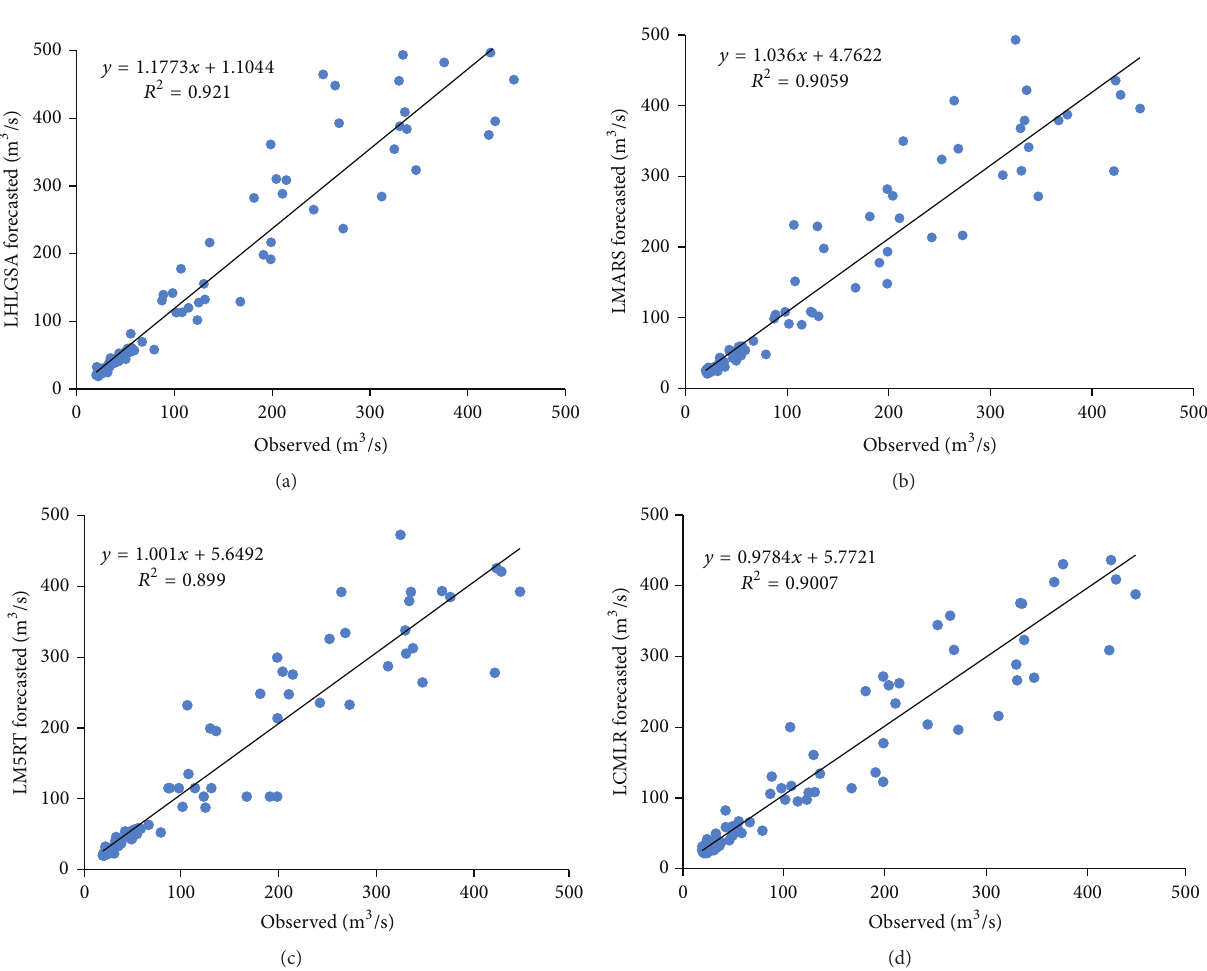
Shyok Basins, respectively. The LM5RT reduced the overall RF RMSE of the M5RT by 4.41% and 2.22% for the Astore and Shyok Basins, respectively. However, in the case of multiple linear regression method, CMLR reduced the overall RF RMSE